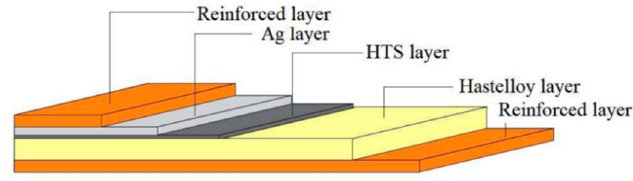
Figure 2. Structural diagram of typical coated superconductor.